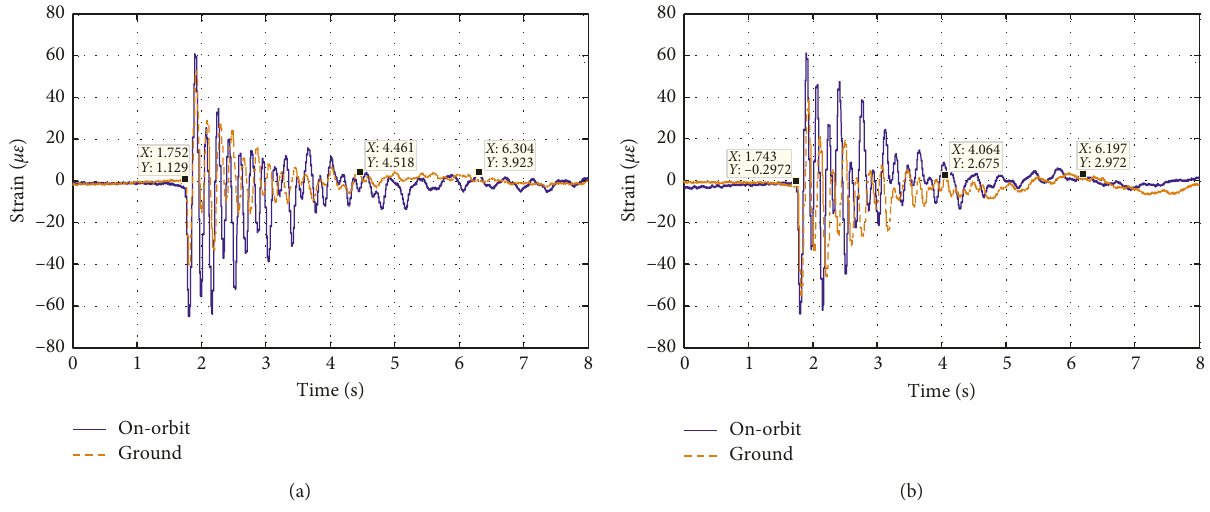
Figure 9: Comparisons of the vibrating strain signals in the time domain. (a) Sensor 1. (b) Sensor 2. Table 1: Comparisons of the measured results obtained in ground and in outer space.